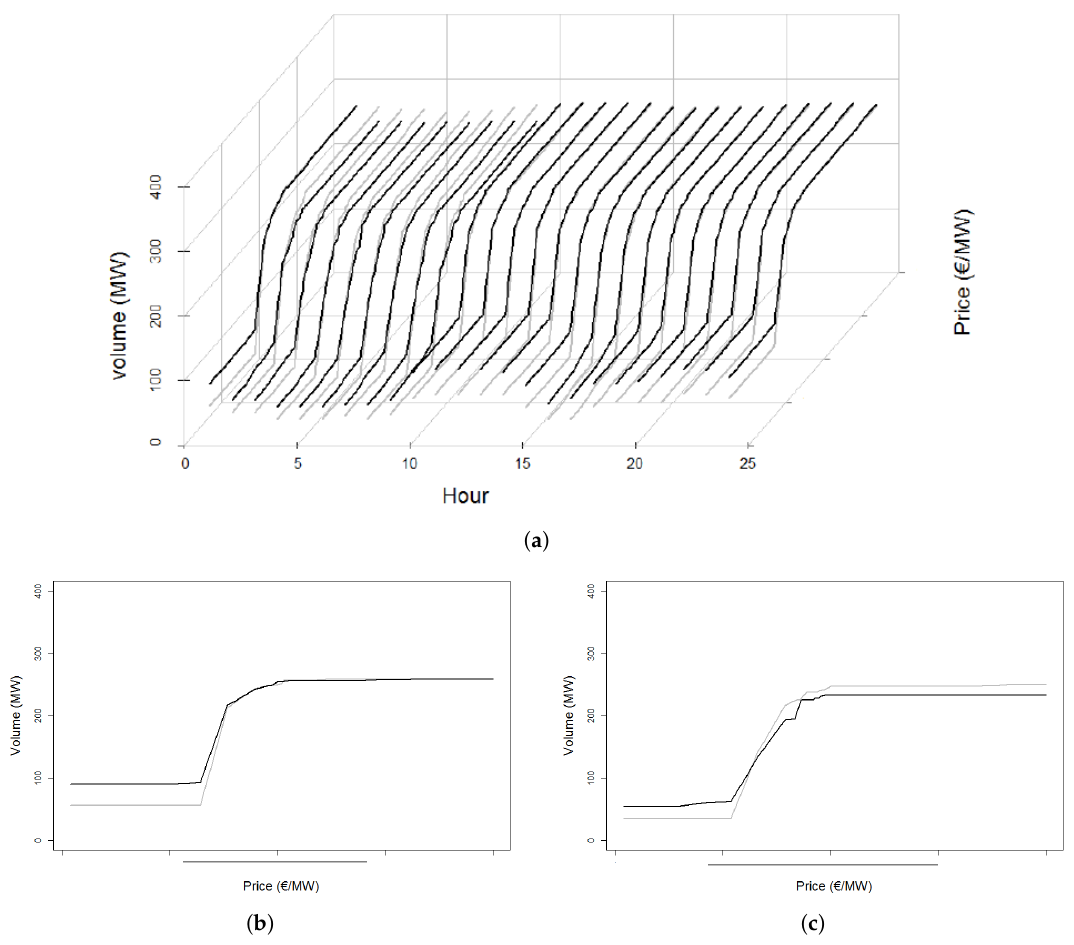
Figure 3. The bid curves for the next day’s operation when using the MILP model (black) and linear relaxation (grey) ( a ). The bid curves for Hour 1 ( b ) and Hour 5 ( c ). The prices have been taken away due to confidentiality, but the grey lines below the price-axis indicate the most likely range of prices for the given